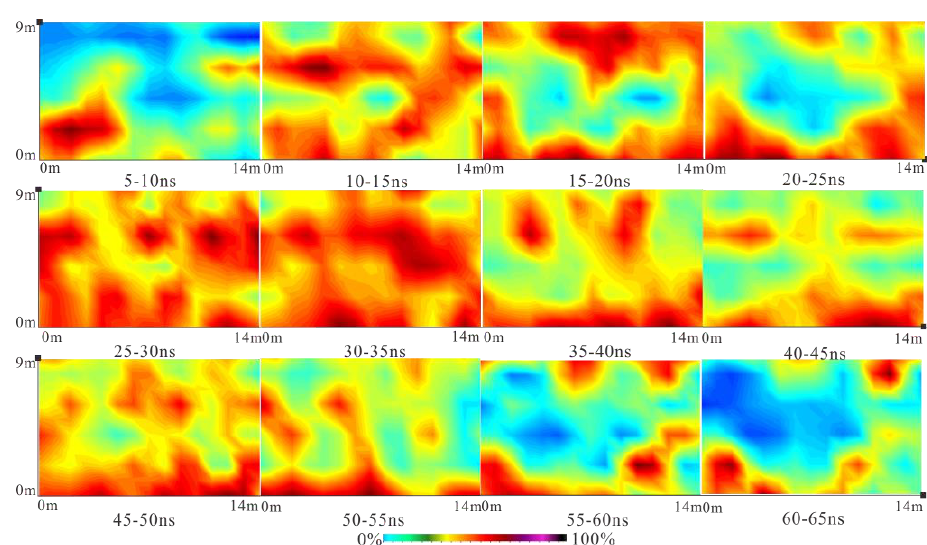
Figure 13. The planar variation characteristics of relative water content at different depths of time.